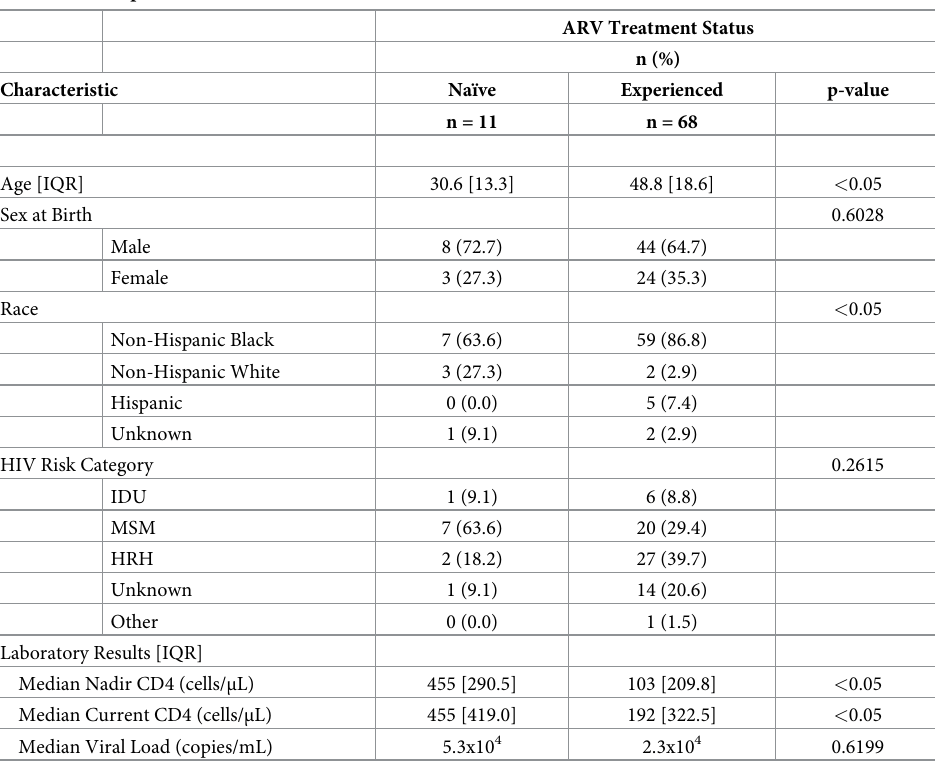
Table 2. Participant characteristics.